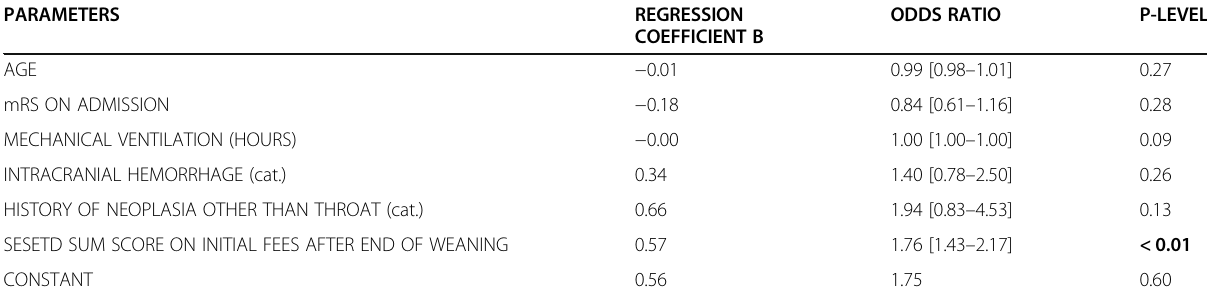
Table 4 Logistic regression analysis for decannulation during stay in the ICU mRS = modified Rankin Scale; cat = categorical; Nagelkerke R 2 : 0.17